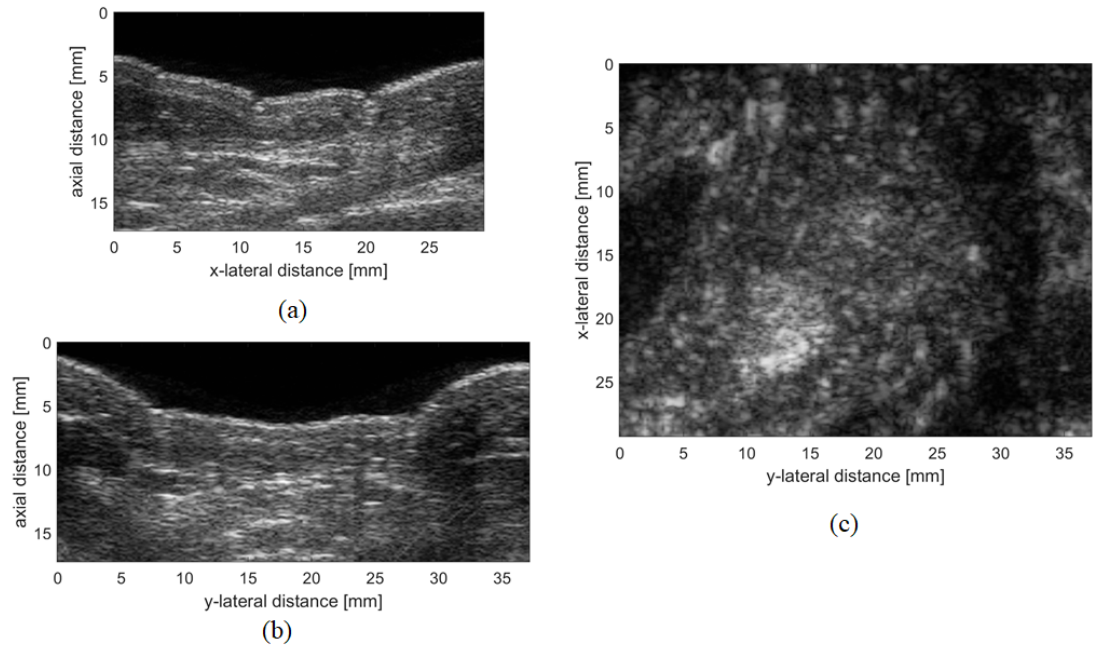
Figure 1. Example of simultaneous renderings of 2D images orthogonal to the three axis extracted from a 3D ultrasound image: ( a , b ) brightness (B)-mode images, and ( c ) C-mode